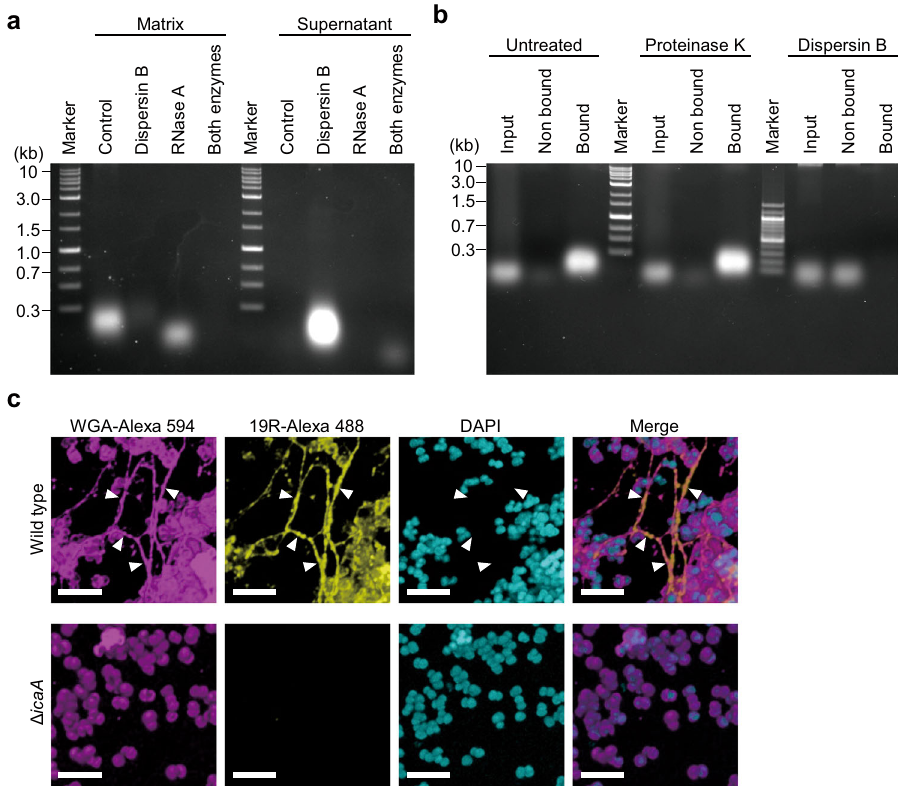
Fig. 5 Polysaccharides capture external RNA in the bio fi lm. a A bio fi lm matrix was extracted from MR10 24-h bio fi lms formed in BHIN. Dispersin B alone, RNase A alone, or both enzymes were added to the bio fi lm immediately before the bio fi lm-matrix extraction. After incubation for 1 h at 37 °C, the treated samples were centrifuged. After centrifugation, the supernatants were collected and the bio fi lm matrices were extracted from the pellets using 1.5 M NaCl. The nucleic acids were analyzed using agarose gel electrophoresis. b RNA pull- down was performed as illustrated in Supplementary Fig. 4. Bio fi lm-associated and nonassociated RNA from MR10 wild type pretreated with proteinase K and dispersin B or left untreated were detected using agarose gel electrophoresis. c The bio fi lms of MR10 wild-type and its isogenic Δ icaA strains were cultured in BHINC supplemented with 19R-Alexa 488 for 24 h at 37 °C. The bio fi lms were stained with WGA-Alexa 594 and DAPI. Subsequently, the bio fi lms were observed by high-resolution CLSM (with Airyscan unit). WGA-Alexa 594 and DAPI stained the polysaccharides and the cell wall (magenta) and DNA (cyan), respectively. 19R-Alexa 488 indicates localization of RNA (yellow). The merged images are also shown. Scale bars correspond to 5 µm. The arrowheads indicate colocalization of polysaccharides and